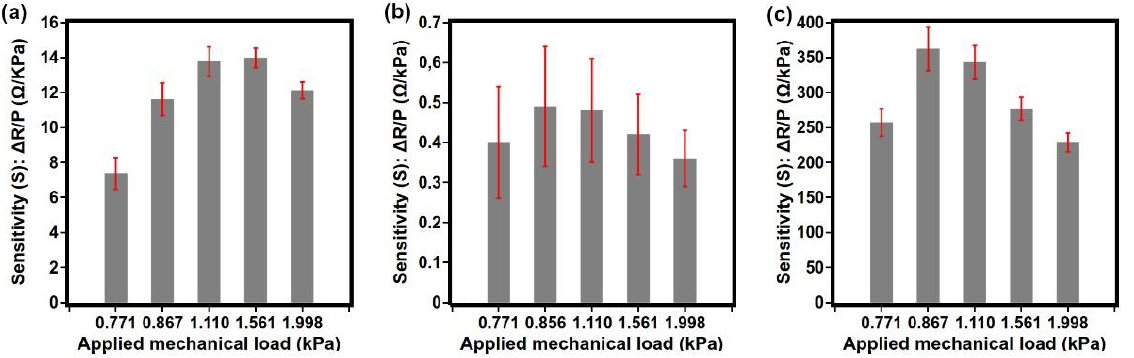
Figure 5. Sensitivity (S) for each load applied to the sensor prototypes; ( a ) EG1, ( b ) GO1 and ( c ) rGO1.